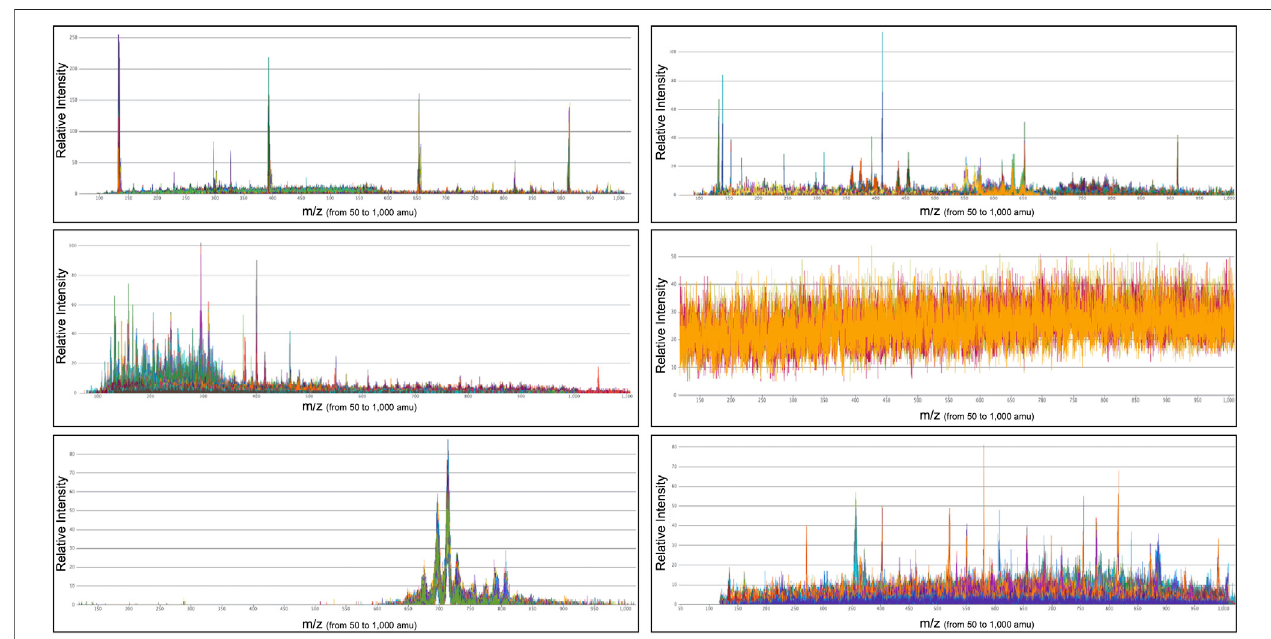
FIGURE 4 | Examples of mass spectra ( x -axis: m/ z , y axis: relative intensity) from a six-cluster clustering algorithm (using agglomerative clustering method). Each subplot represents several mass spectra that were clustered together. Some of these clusters are clearly identi fi able. The fi rst one (top left) represents mass spectra of thecalibrationdata.Thebottomleftonerepresentsamass-rangeselectionexperiment.Themiddlerightonegathershighlynoisydata.Thegoalofthis fi rst fi lteringphase is to select the most “ interesting ” data that scientists will then focus on during their limited time between martian operations.